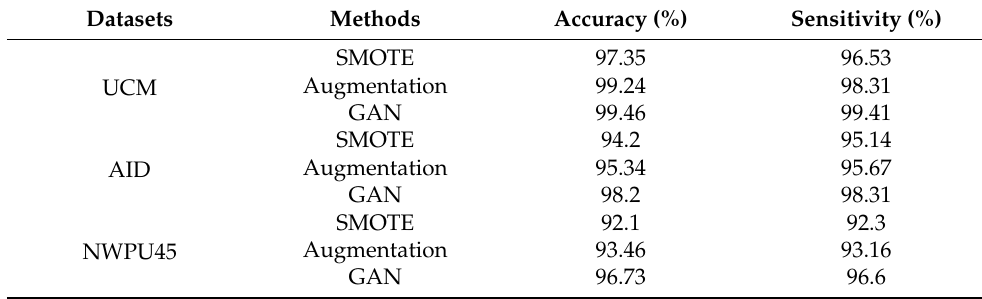
Table 3. Sampling techniques for scene classification.